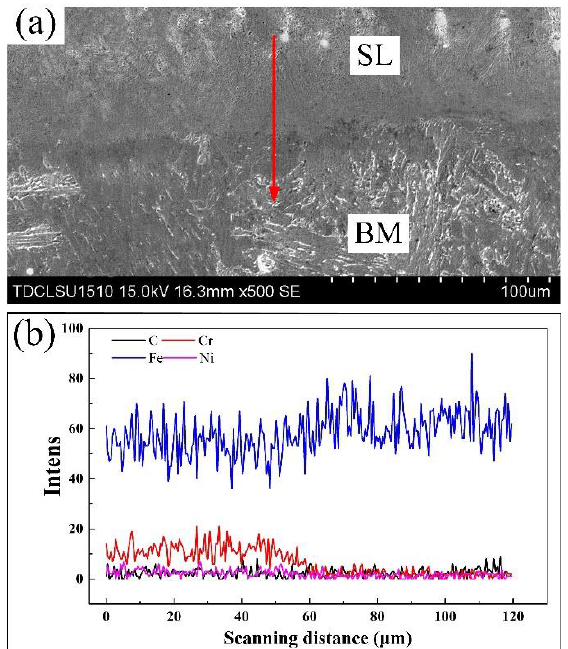
Figure 6. EDS line scan analysis of major alloying elements. ( a ) Scanning position diagram; and ( b ) element distribution.